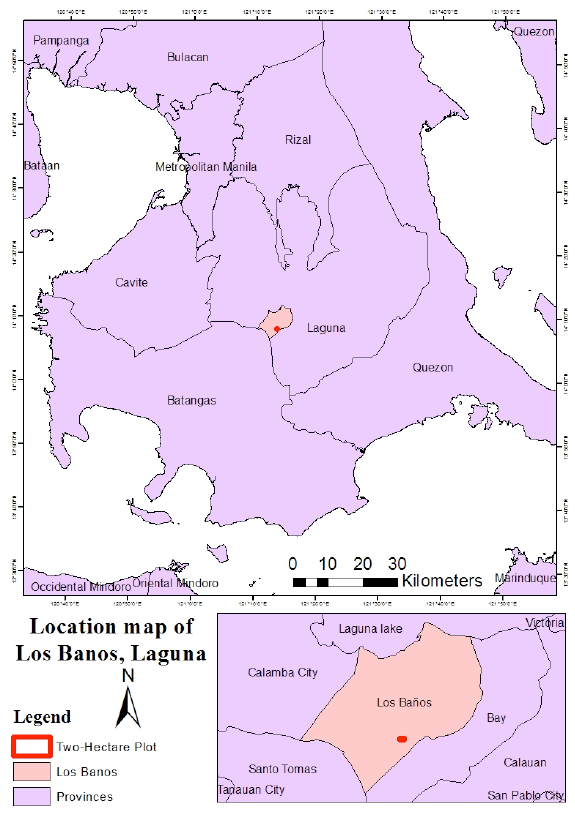
Figure 1: Location Map of the 2-hectare forest plot at Mt. Makiling, Los Baños,